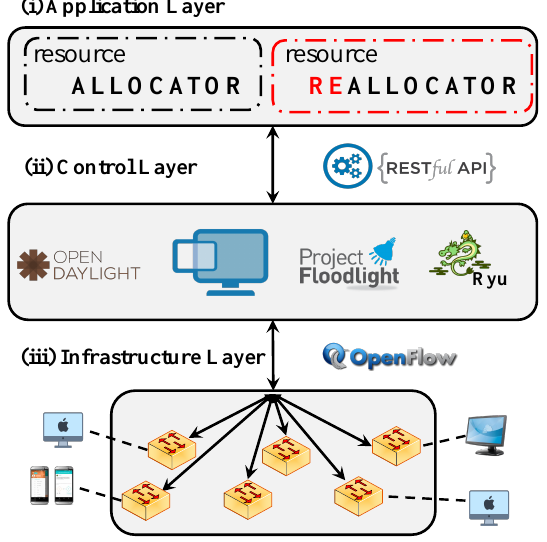
Figure 1. The architecture of the proposed scheme. The architecture is composed of three main layers (i) Application Layer (the upper layer); (ii) Control Layer (the middle layer); and (iii) Infrastructure Layer (the down layer). Our main contributions are in the Application